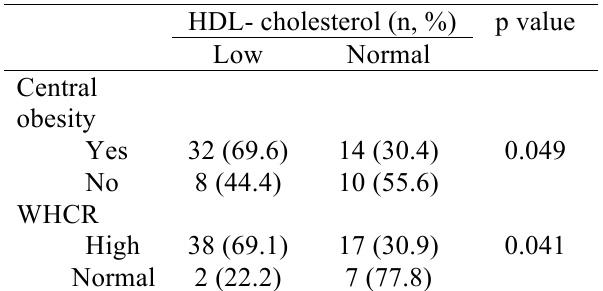
Table 3c Association between central obesity and WHCR to HDL-cholesterol